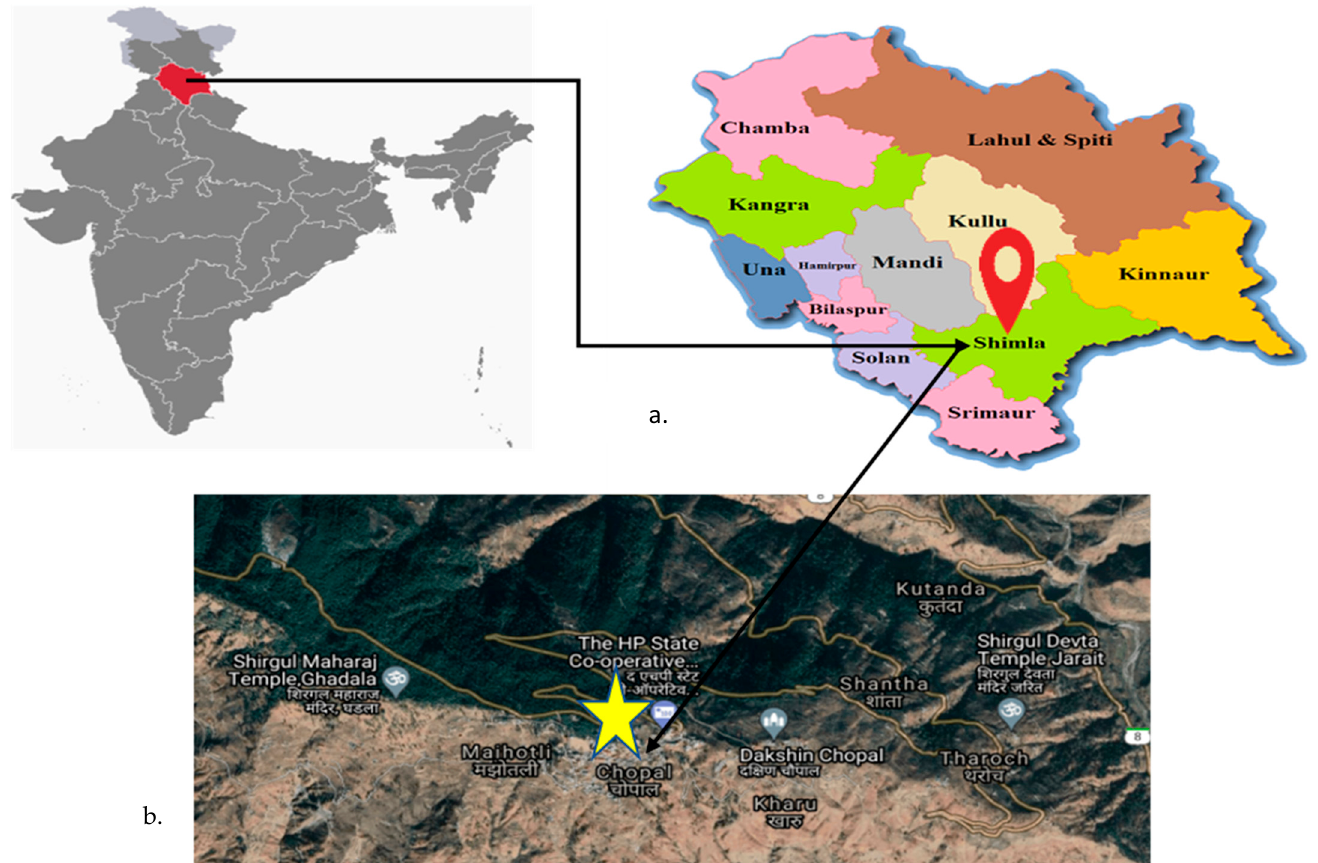
Figure 1. ( a ) Geographical identification of the study area; ( b ) satellite map.